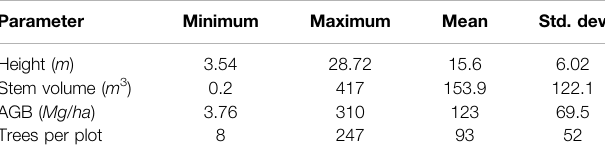
TABLE 1 | Summary statistics of the various parameters collected during the fi eld campaigns (Std. dev represents standard deviation).